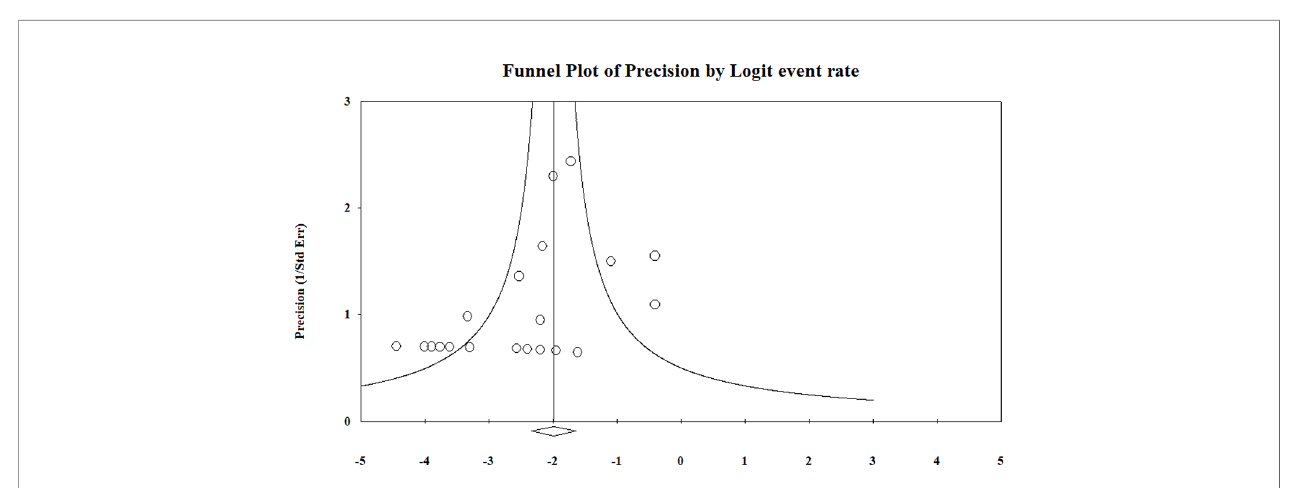
FIGURE 6 | Summary of the funnel plot of aggressive treatment recurrence